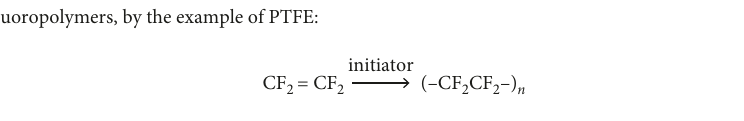
Figure 3: Polymerization of TFE.